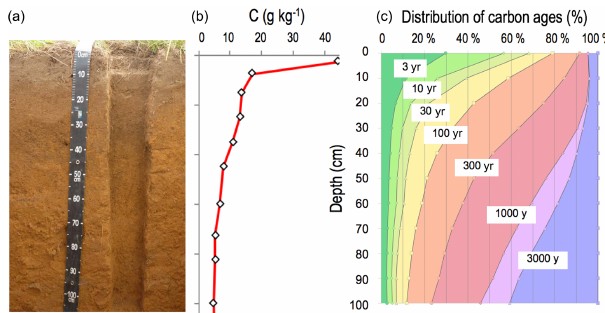
Figure 1. Grassland soil profile (a) . The vertical distribution of or- ganic carbon in this soil (b) . A current distribution of carbon ages ( c , based on data from Balesdent et al., 2018).